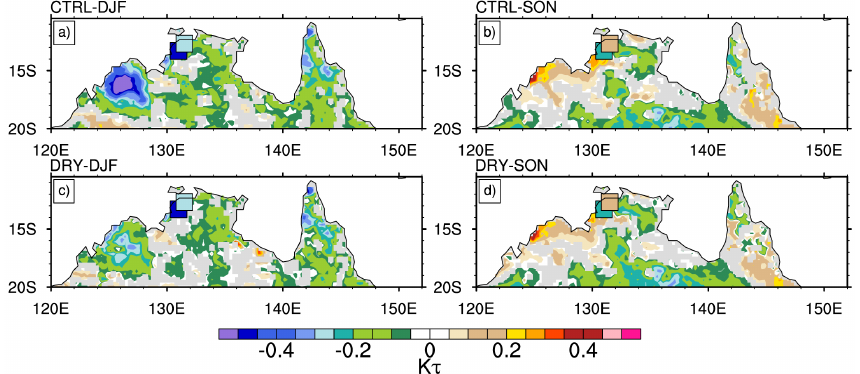
Figure 8. The ensemble median Kτ correlation metric between the morning first layer soil moisture (SM 1 ) and the afternoon computed LCL from (a) CTRL over DJF, (b) CTRL over SON, (c) DRY over DJF, and (d) DRY over SON. The black outlined squares in (a–d) denote the values from the flux tower sites. Only statistically significant (95% confidence level) results are shown in (a–d) .